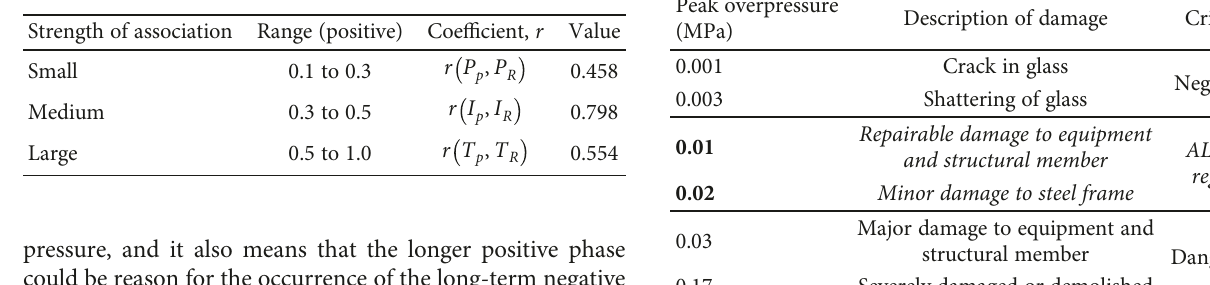
Table 5: The results of correlation coe ffi cient for explosion pressure parameters.